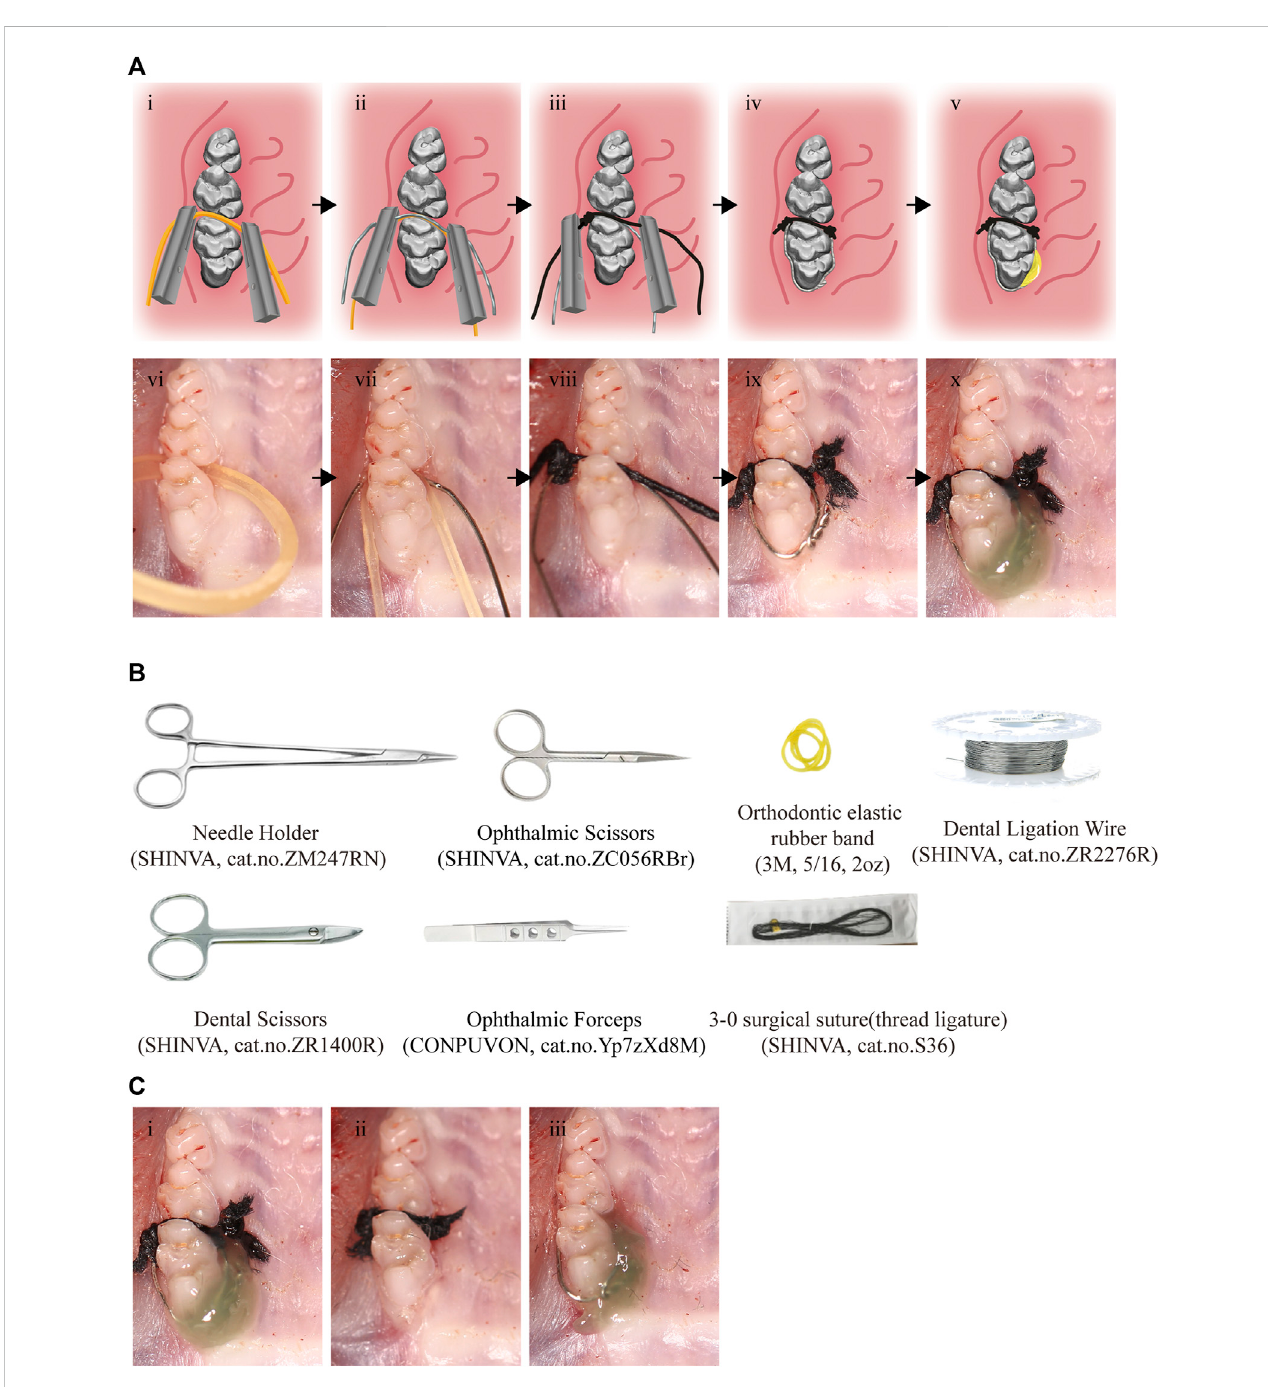
FIGURE 1 Procedures and tools for the effective and reliable experimental rat model. (A) i-v, The pattern diagram of the modeling procedures. vi-x, The photo of modeling procedures.Blackarrowsindicatethesequenceofsteps. (B) The toolsfor modeling. (C) The modeling completedphotos ofthemodi fi edmodel(i), thread ligature model (ii) and the metal steel model